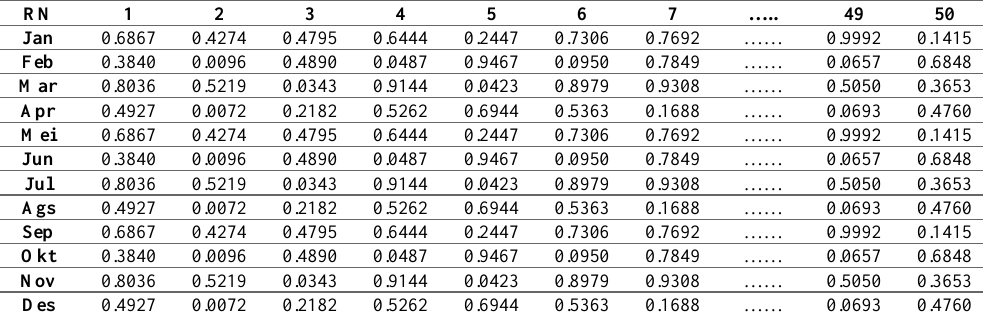
Table 8. Probability data interval